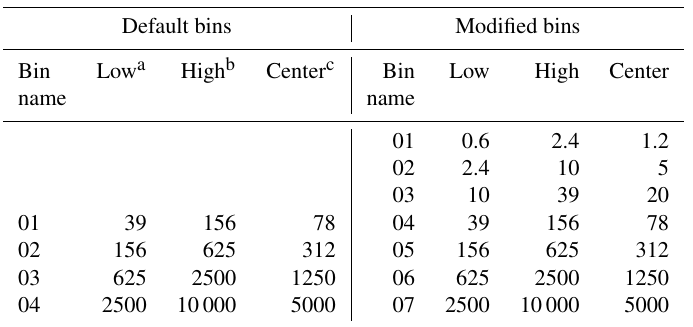
Table A2. Description of aerosol size bins in